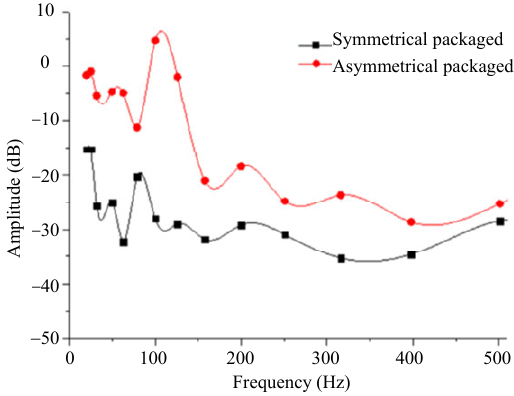
Fig. 9 Acoustic response of the DFB fiber laser acoustic